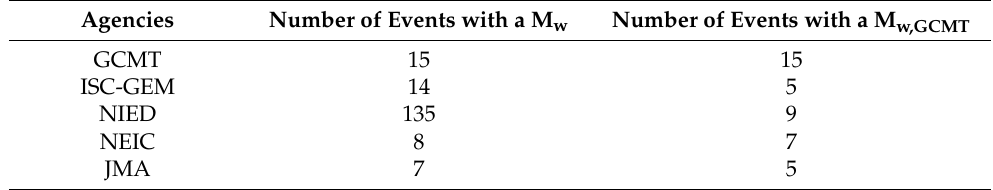
Table 2. Number of events with a listed M w categorized by agency. Agencies